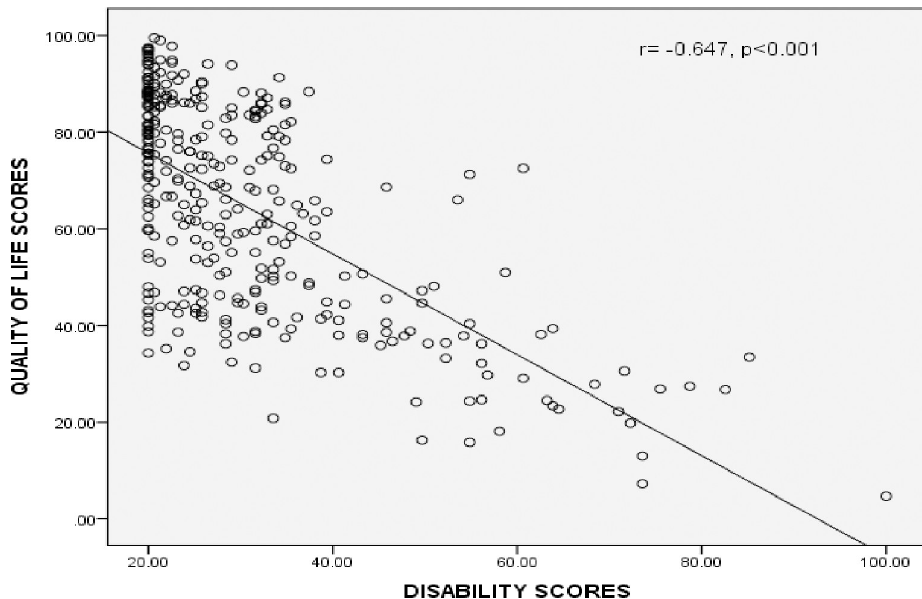
Fig 2. Correlation of total Quality of life scores with total disability scores among respondents with onchocerciasis.